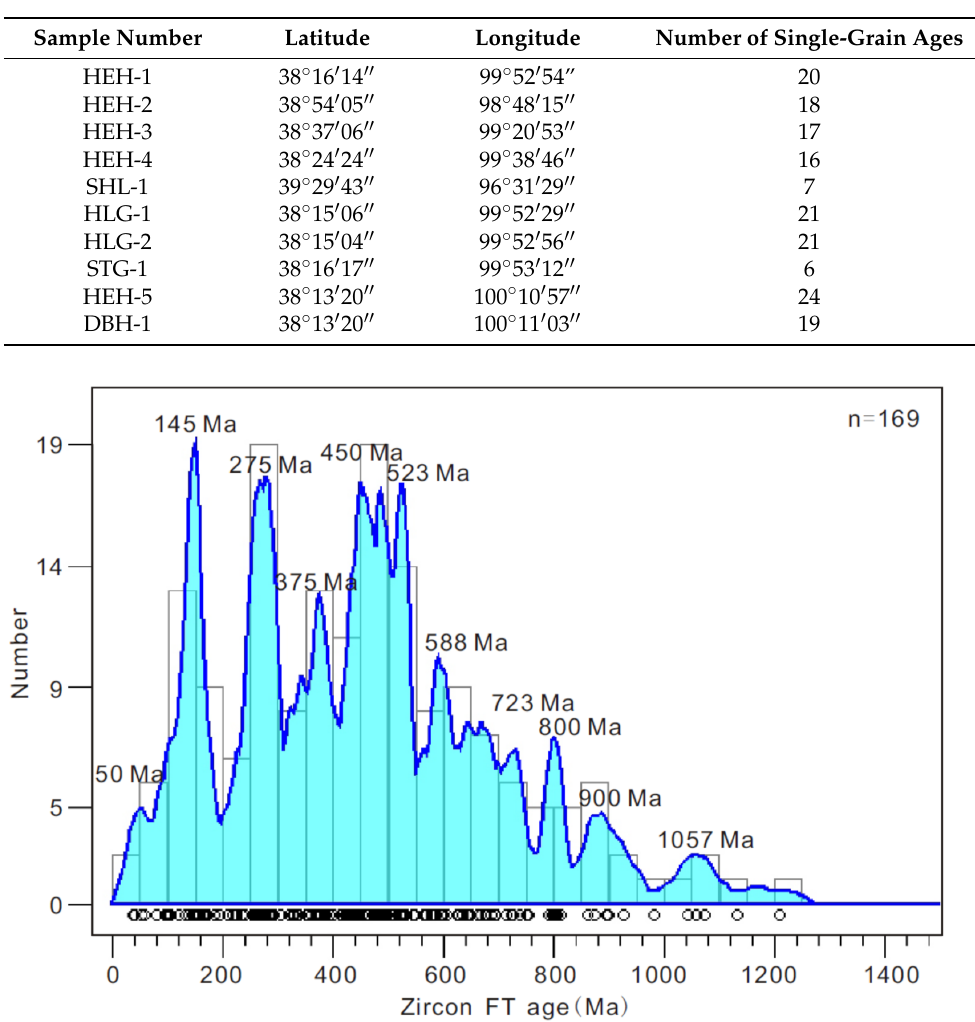
Table 1. Collected detrital ZFT samples.